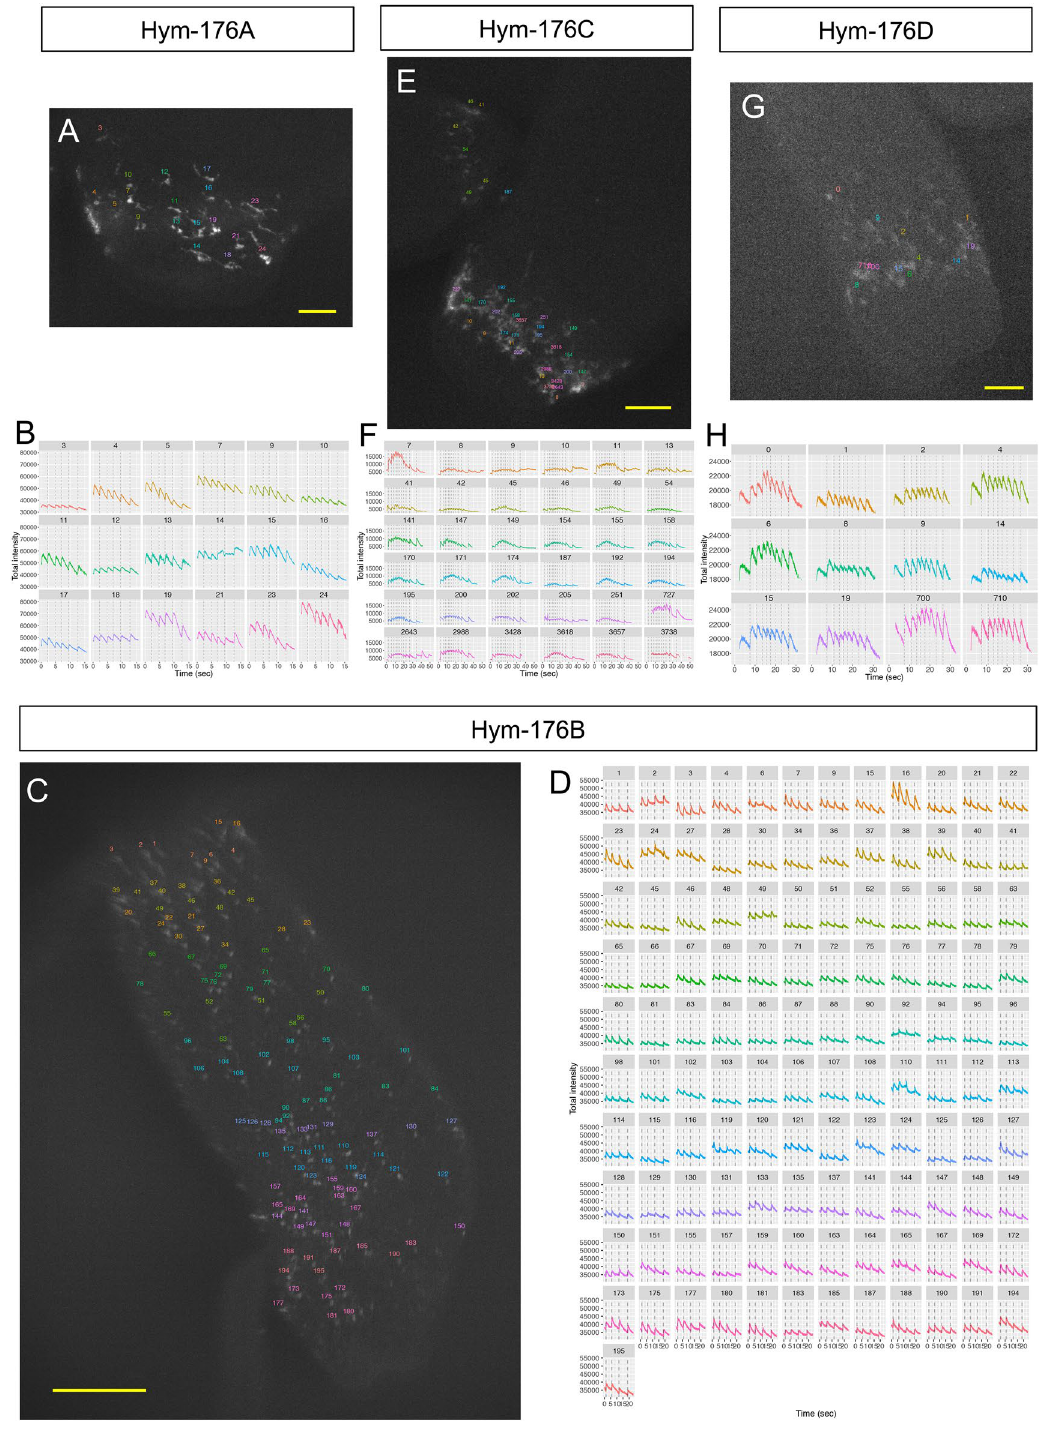
Figure 1. Simultaneous neuronal excitation of the peptidergic neuron subsets expressing neuropeptide gene Hym-176 paralogs. Hym-176A -expressing neuron subset ( A,B ). Hym-176B -expressing neuron subset ( C,D ). Hym-176C -expressing neuron subset ( E,F ). Hym-176D -expressing neuron subset ( G,H ). Position of tested neurons ( A,C,E,G ). Neuronal activity (total intensity of GCaMP) is shown, with the vertical dashed lines indicating the average starting time of excitation of all tested neurons in each subset (B: 2.22, 4.79, 6.81, 9.38, 12.50 s; D: 1.09, 5.75, 11.72, 18.59 s; F: 2.13, 5.57, 7.98, 9.72, 11.60, 13.00, 14.83, 16.94, 19.45, 22.27, 26.26, 33.86 s; H: 7.37, 10.70, 13.37, 15.32, 17.41, 19.77, 22.80, 26.15 s) except neuron #41–54 in F (see text). The number in the strip and the color of the excitation profile for each subset correspond to cells in each one of A, C, E and G. Bar: 30 µm in A, 200 µm in C, 100 µm in E and 50 µm in